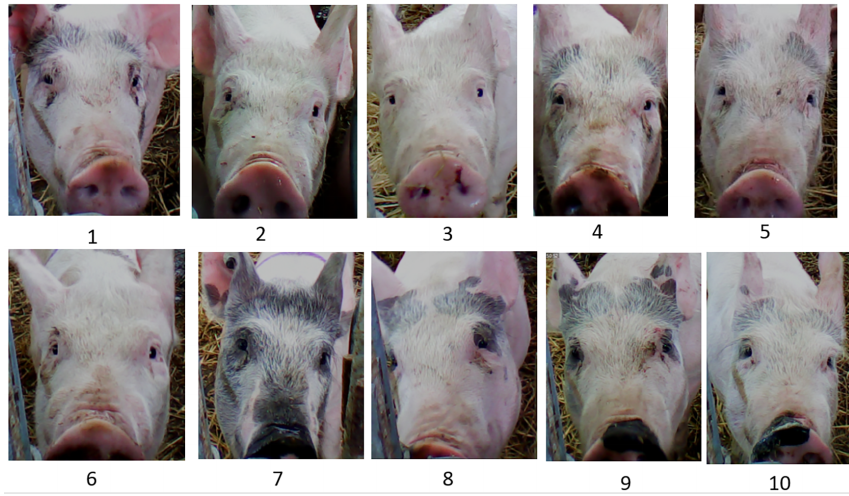
Figure 3. Set of images used for facial recognition